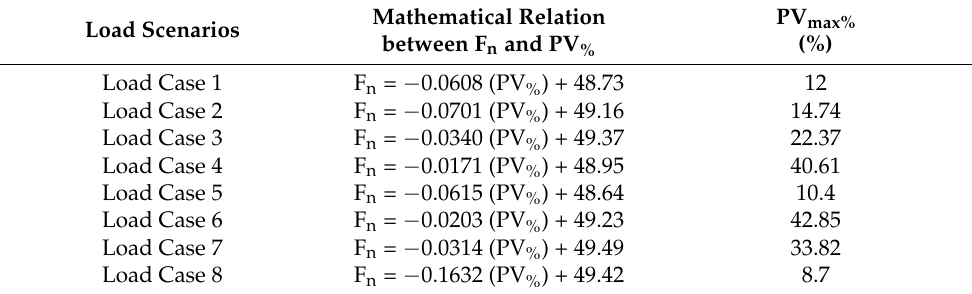
Table 5. Summary of calculated PV max% values for various load